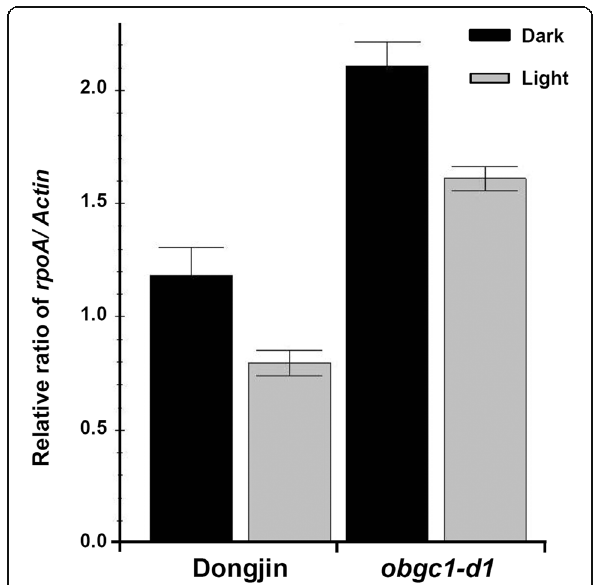
Fig. 4 Relative ratios of chloroplast-to-nuclear DNA copy in obgc1-d1 mutants. The relative ratios of chloroplast DNA ( rpoA ) to nuclear DNA ( Actin ) copies were normalized to the wild-type values. The copy numbers of rpoA and Actin were determined using qRT-PCR with their gene-specific primers. Black and gray bars indicate the dark- and light-grown plants, respectively. Error bars represent the mean ± SD values calculated from three independent